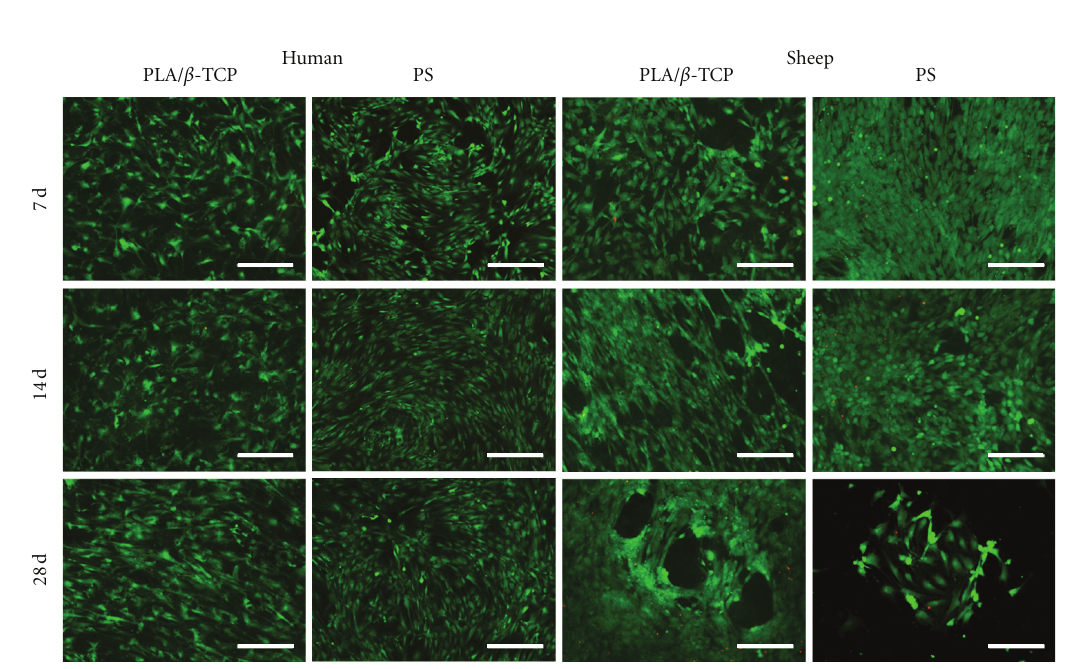
Figure 3: Representative images of viable (green fluorescence) and dead (red fluorescence) adipose stem cells (ASCs) attached to composite and polystyrene (PS) samples. Scale 100 μ